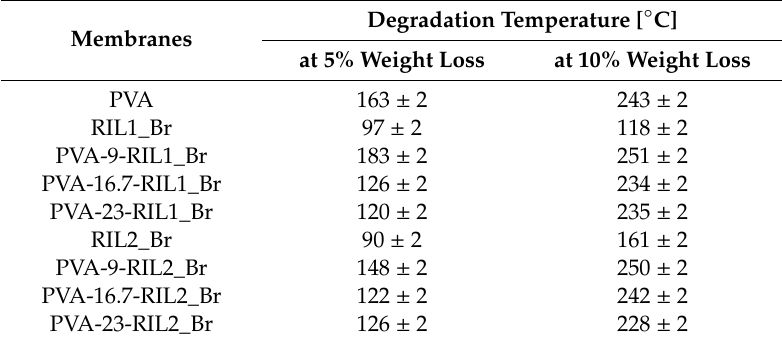
Table 2. Degradation Temperatures of PVA-RIL1_Br and PVA-RIL2_Br Films. Degradation Temperature [ ◦ Membranes